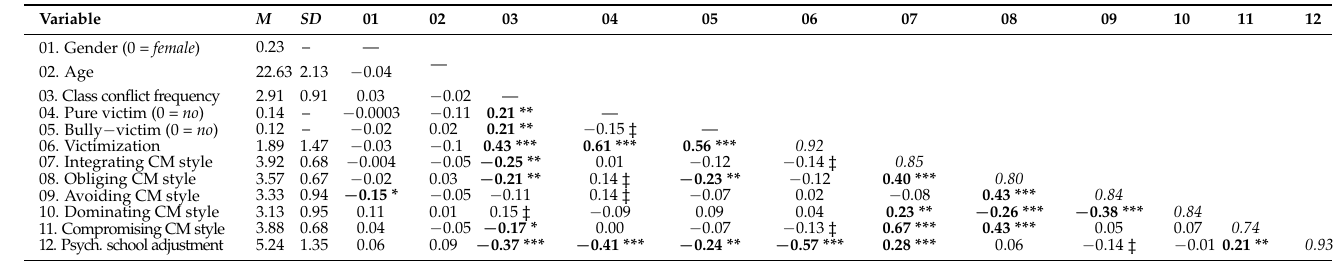
Table 1. Descriptive Statistics and Bivariate Zero-Order Correlations of the Main Study Variables.